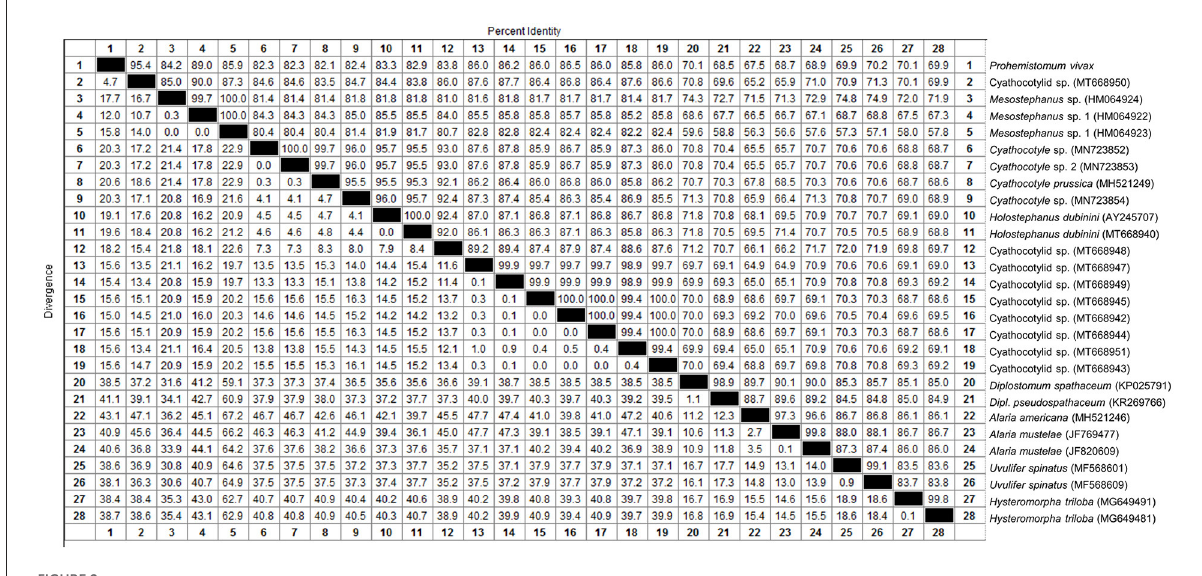
FIGURE2 Pairwise distance comparison of IT1, 5.8S, and IT2 region of Prohemistomum vivax from experimentally infected pigeons to that of other Diplostomata